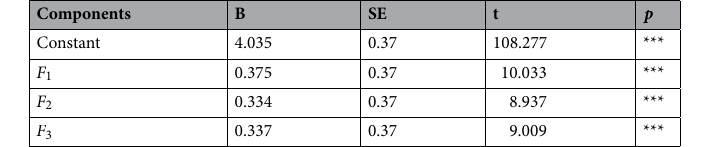
Table 8. Regression coefficient. **Means a significant test that passes 0.05, and ***means a significant test that passes 0.01.